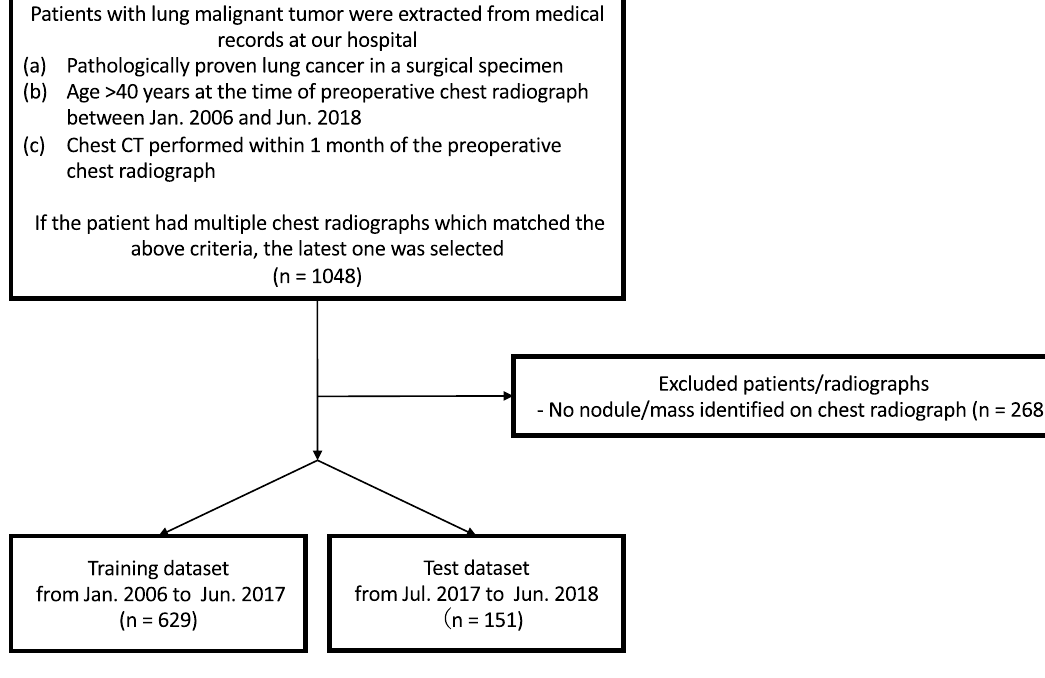
Figure 1. Flowchart of dataset